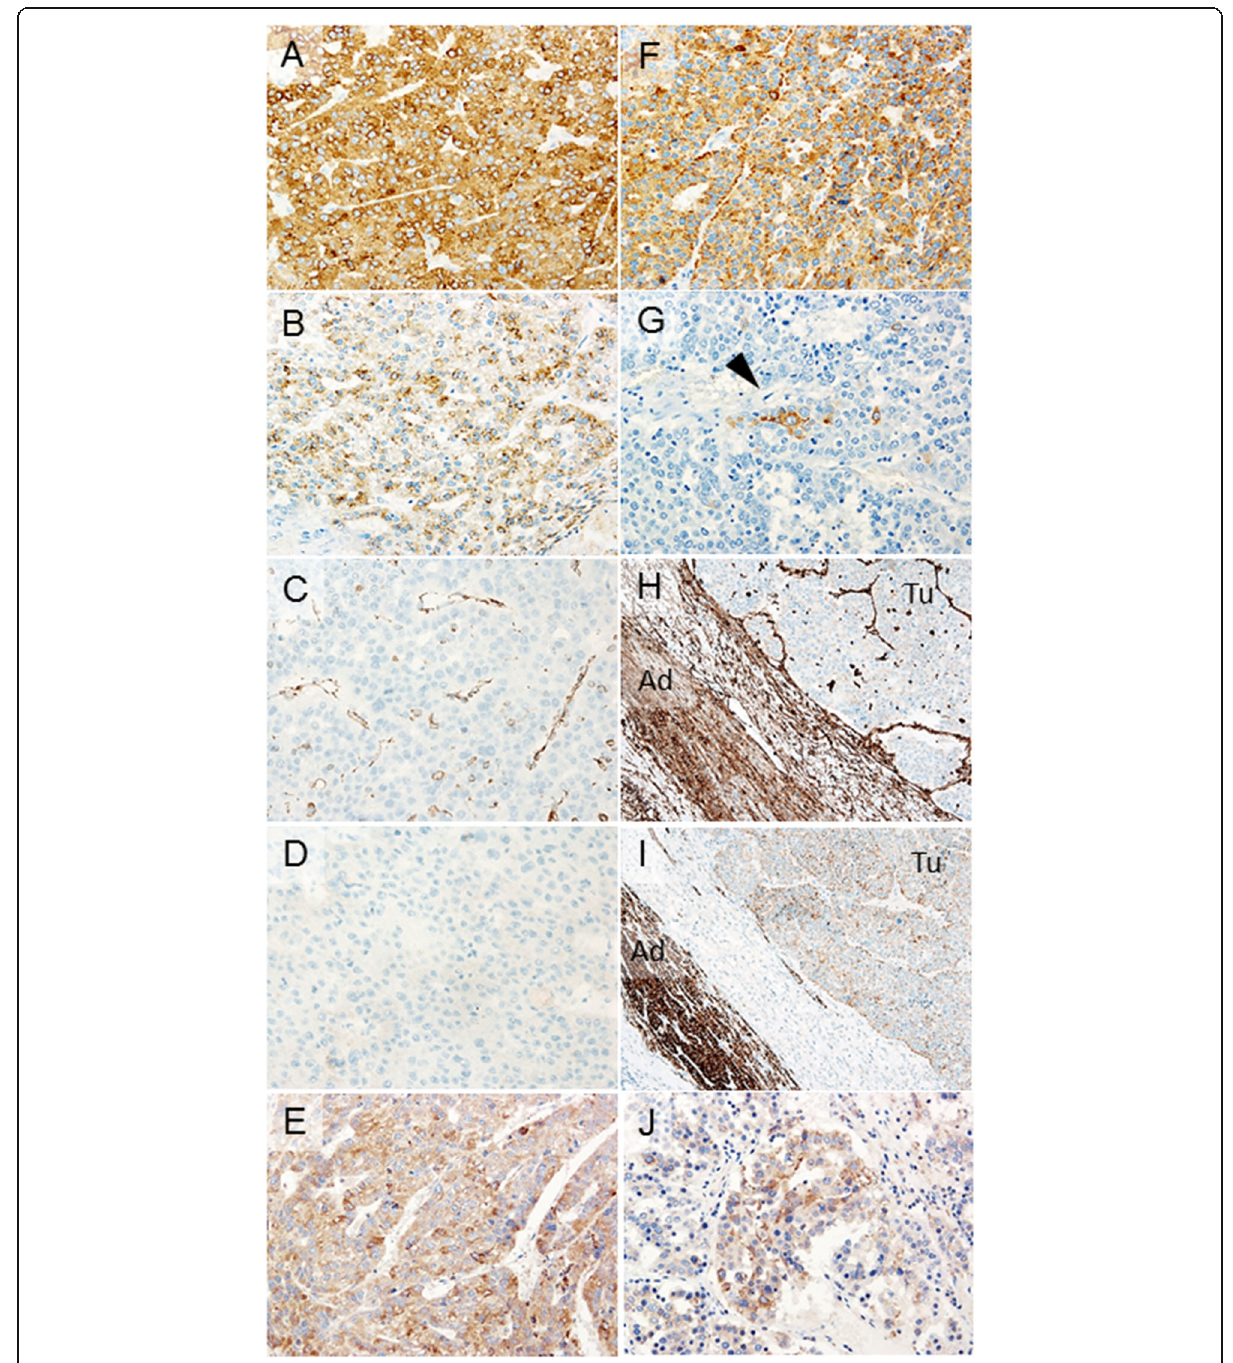
Fig. 4 Immunohistochemical findings of HCC and adrenal tumor. a – e HCC and f – j adrenal tumor. a , f HCC ( a ) and adrenal ( f ) tumor are both diffusely positive for Glypican-3 (× 200). b , g Alpha-fetoprotein is partially expressed in the HCC ( b ) and only focally in the adrenal tumor ( g , arrowhead) (× 200). c , d , h , i Vimentin was negative for HCC ( c ) and adrenal ( h ) tumor, and Melan-A ( d ) was also negative for HCC. In the adrenal tumor, slight positivity of Melan-A was observed ( i ), but the intensity of staining was clearly weak compared with that in the normal adrenal glands. ( c , d × 200, h , i × 100; Ad, adrenal glands; Tu, tumor) e , j Positivity of CD133 is detected in both HCC ( e ) and adrenal ( j ) tumor (×